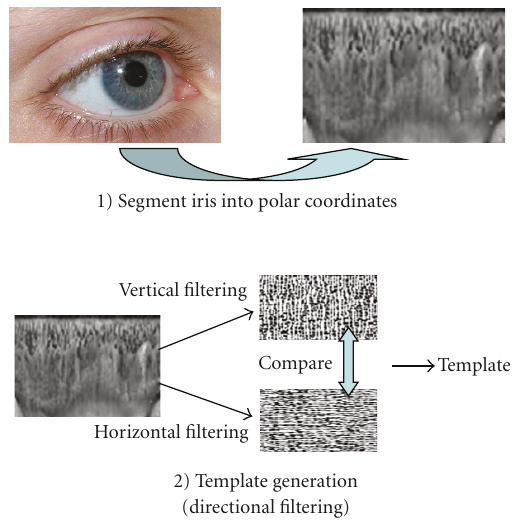
Figure 2: Red iris recognition algorithm. Visible is the associated two dimensional encoding of the iris image into energy data [14].